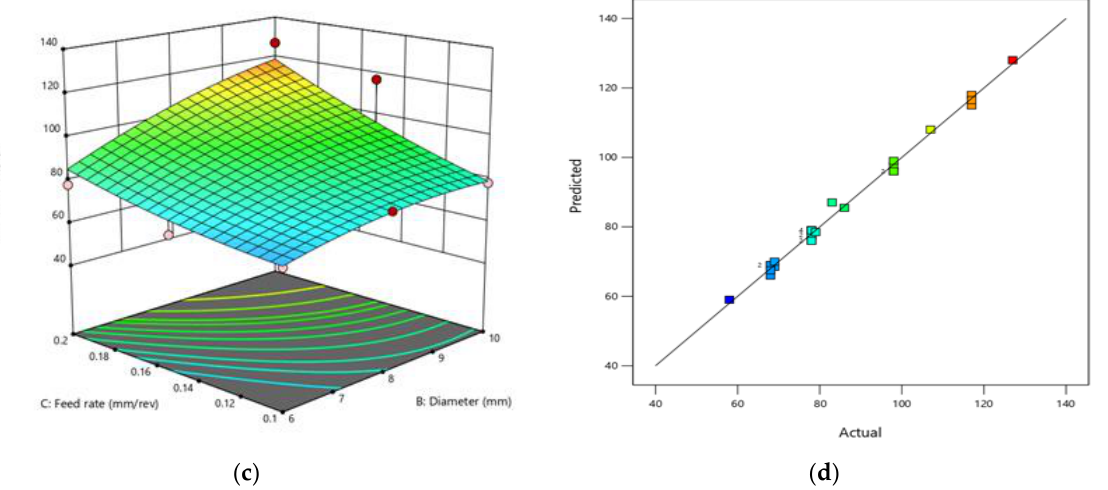
Figure 9. The 3D surface plots of the factors that effect thrust force, including the interactions between spindle speed and diameter ( a ), feed rate and spindle speed ( b ), and feed and diameter ( c ). Actual vs. predicted thrust force ( d ).